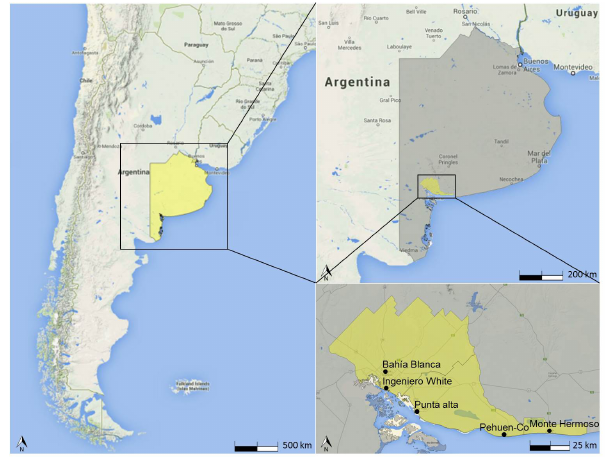
Fig. 3 . Location of the Argentinian social-ecological